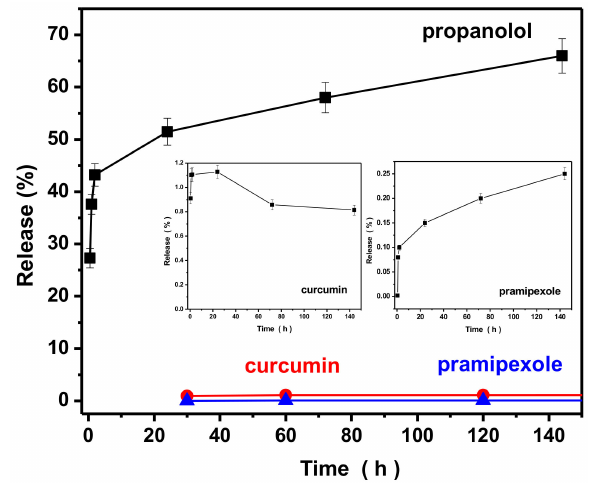
Figure 4. Drug release rate of model drugs from nanoparticles of silk fibroin.